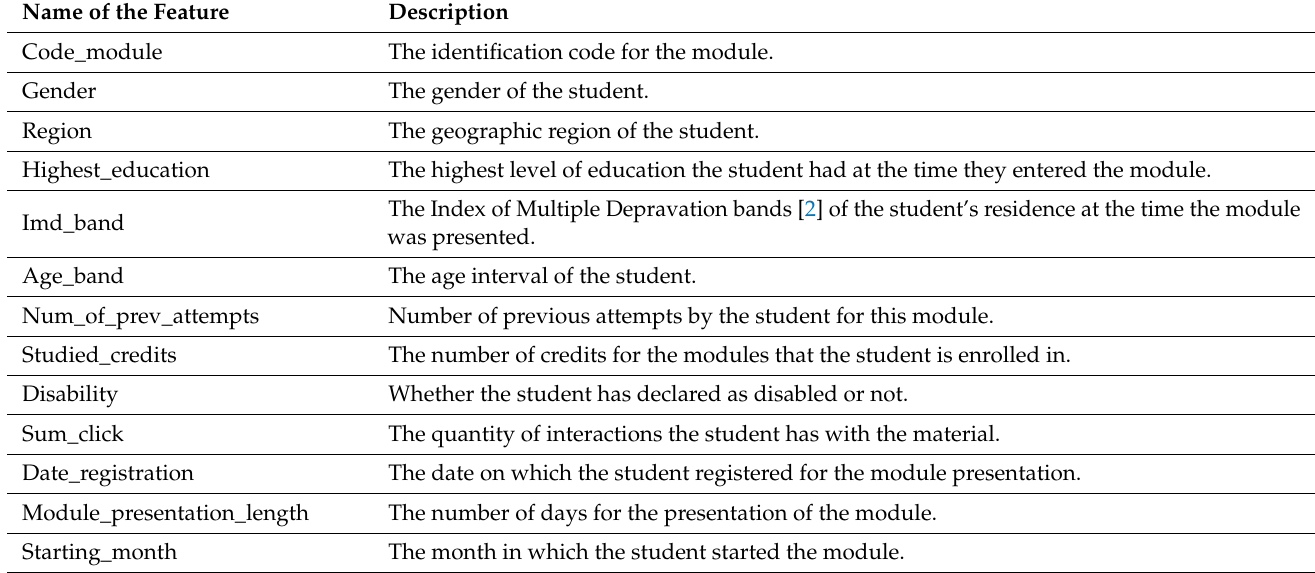
Table 2. The features selected for the training of the model.